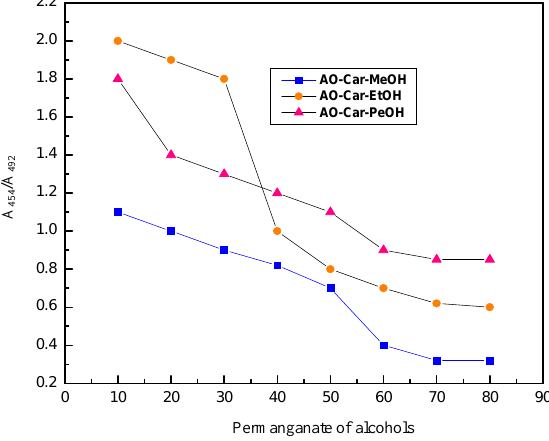
Figure 7. Reversal of metachromasy in AO-NaCar system on addition of alcohols